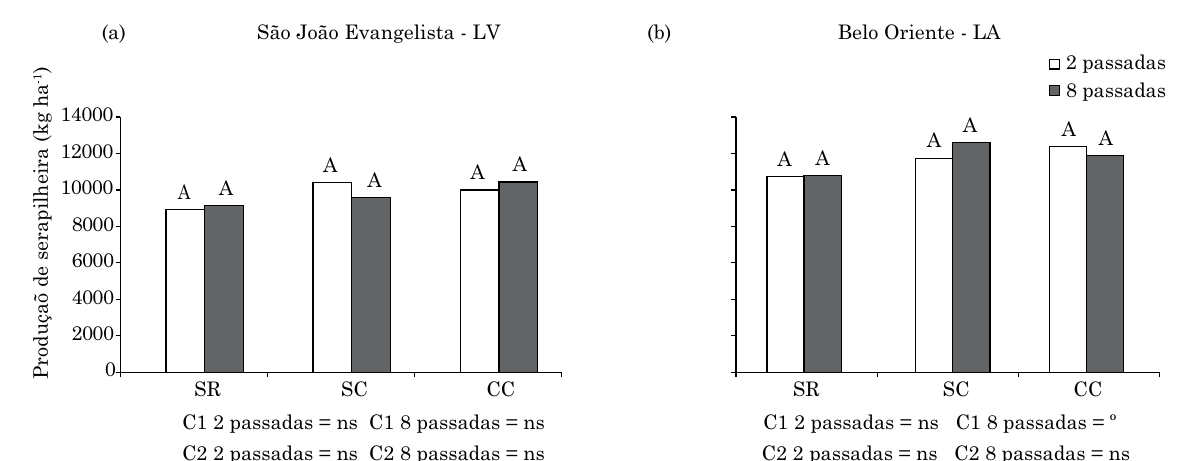
Figura 2. Produção de matéria seca de serapilheira após duas ou oito passadas do forwarder sobre resíduo da colheita do eucalipto sem casca (sc); resíduo com casca (cc); e solo sem resíduo (sr) de um latossolo vermelho em são João evangelista, Mg, aos 5,61 anos de idade do plantio e de um latossolo amarelo na região de belo oriente, Mg, aos 5,88 anos de idade do plantio. c1: sem resíduo (sr) vs . com resíduo (sc e cc); c2: resíduo sem casca (sc) vs . resíduo com casca (CC). ° e ns: significativo a 10 % e não significativo até 10 %, respectivamente, pelo teste F. Médias com a mesma letra maiúscula não diferem entre si quanto ao número de passadas do forwarder sobre a mesma disposição de resíduo e idade, pelo teste F